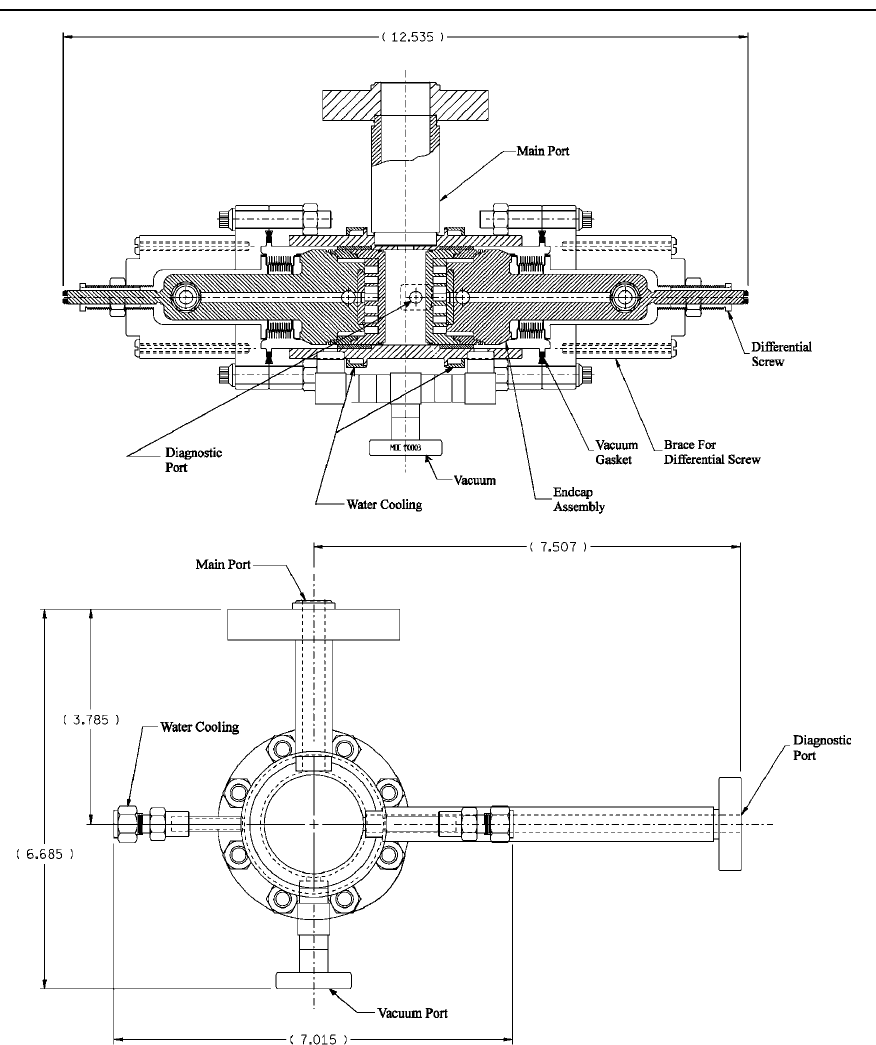
FIG. 5. Assembly schematic of cavity with end caps. The sideview of the cavity is shown on the bottom. All dimensions are in inches.